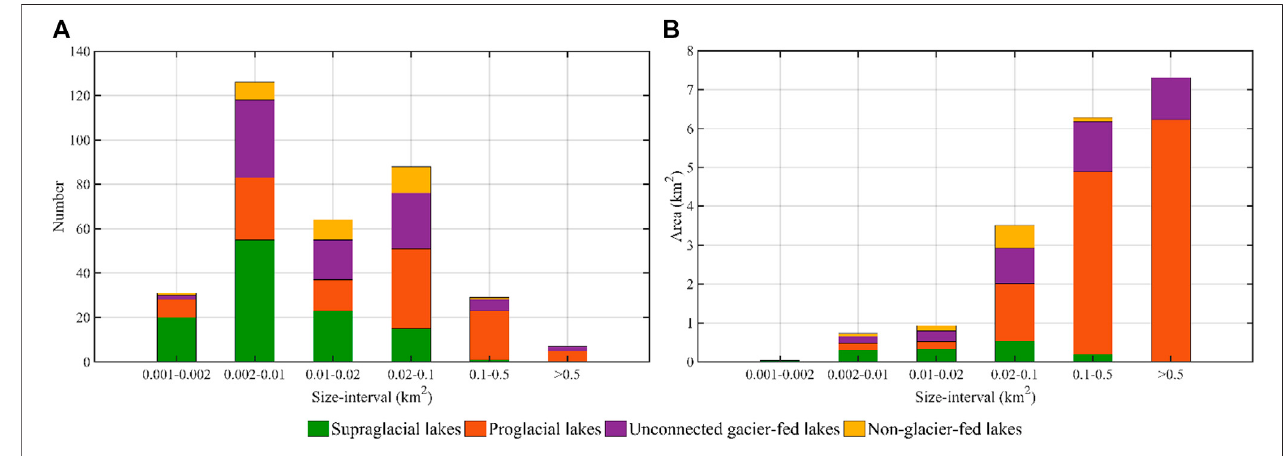
FIGURE 5 | The frequency and area of glacial lakes according to different size interval and